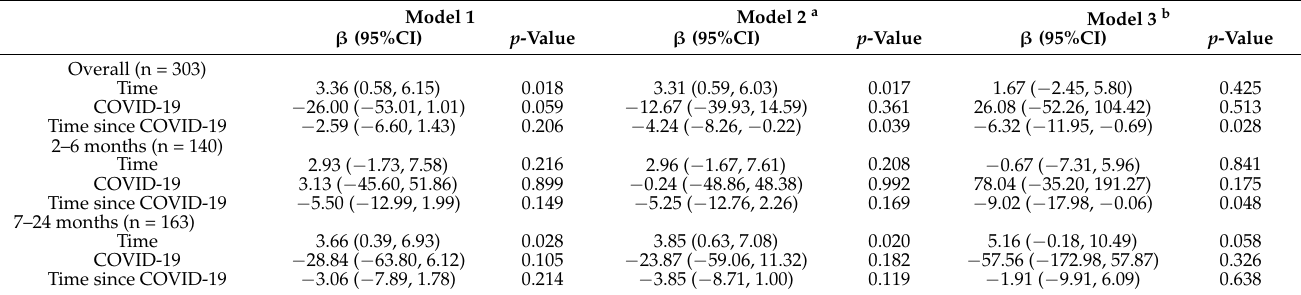
Table 3. ITS analysis of trends in serum 25(OH)D level in infants and toddlers in Hong Kong before and after the COVID-19